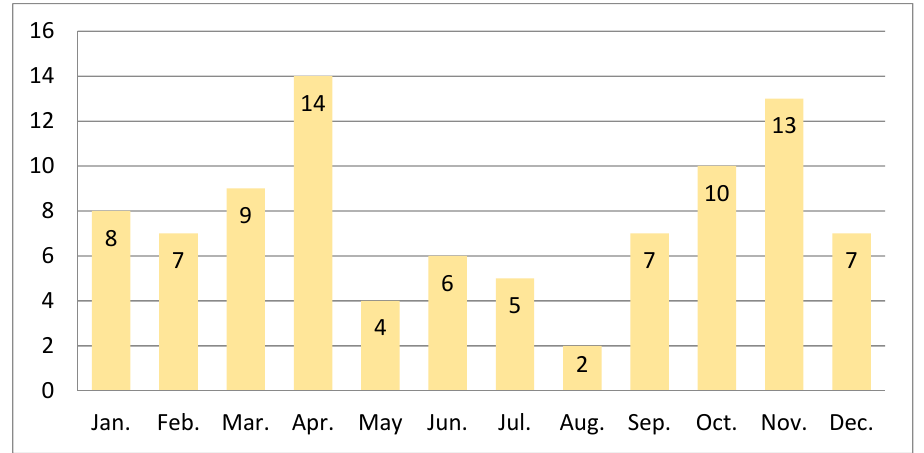
Figure 4. Cumulative numbers of single ventricle cases formed in consecutive months in years 2006– 2019 ( n = 92, data from our single unit). Higher frequency among parous with the last menstrual period in fall/winter season of 58 vs. 34 in spring/summer season ( p = 0.014, chi-square).